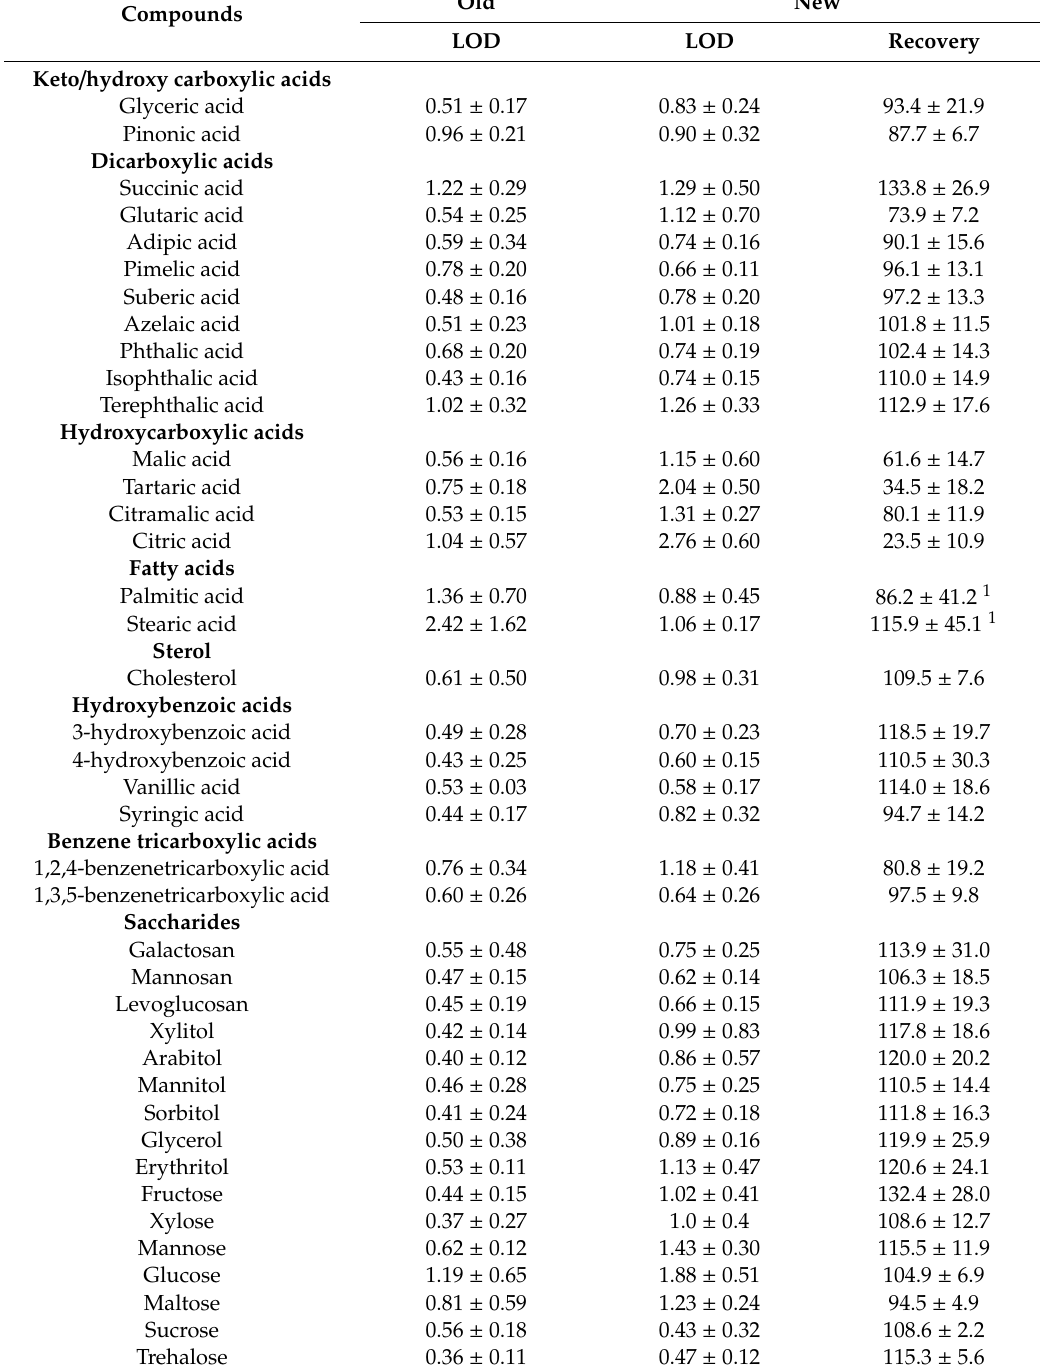
Table 1. Limit of detection (LOD, ppm ± SD ppm) of target analytes by the original and the revised method and recovery (% ± SD%) by the revised